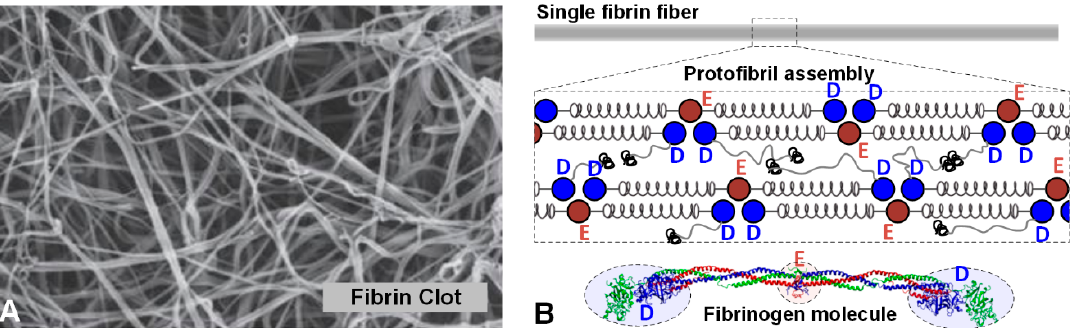
Figure 1. ( A ) Scanning electron microscopic image of a human fibrin clot [13]. ( B ) Multiscale arrangement of a fibrin fiber. Hierarchical arrangement of fibrin(ogen) assembling into protofibrils, and lateral aggregation to form fibers is shown schematically. A molecular model of the fibrinogen molecule is shown below with the D-region and E-region highlighted.